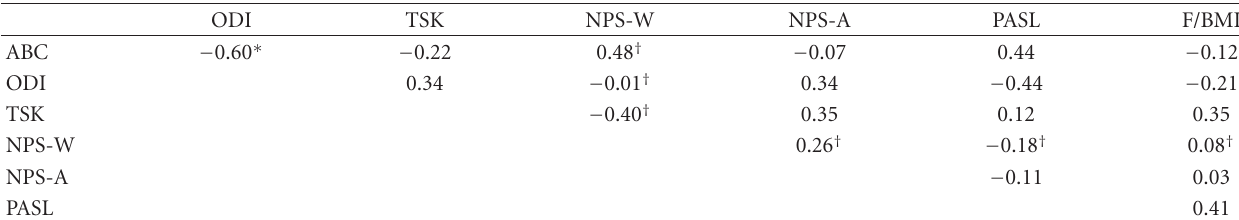
Table 3: Intercorrelations among psychobehavioural and disuse variables in the CLBP group.